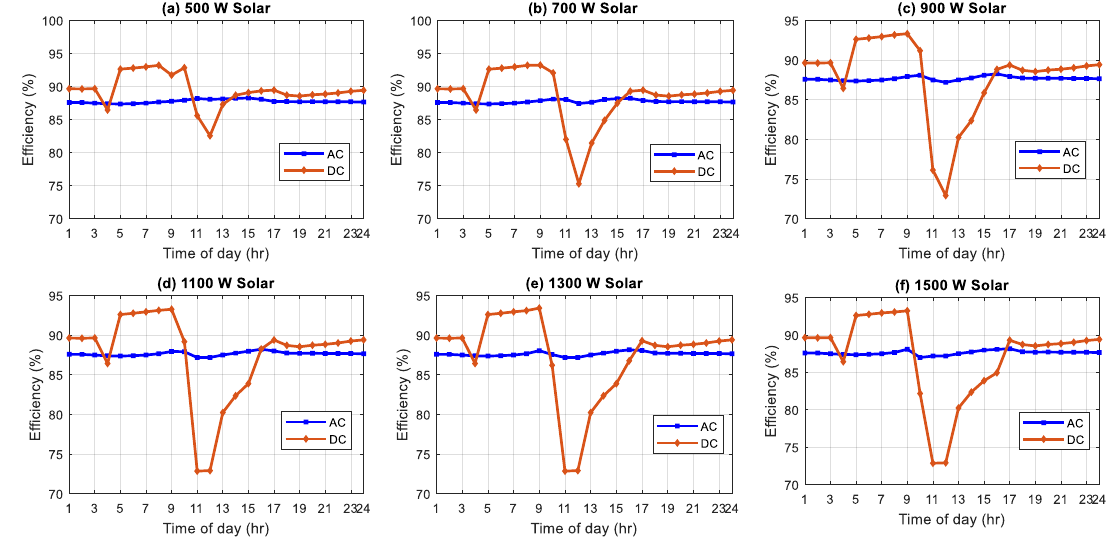
Figure 6. AC vs. DC system efficiency with varying solar capacity: ( a ) 500 W, ( b ) 700 W, ( c ) 900 W, Figure 6. AC vs . DC system efficiency with varying solar capacity: (a) 500 W, (b) 700 W, (c) 900 W, (d) ( d ) 1100 W, ( e ) 1300 W, and ( f ) 1500 1100 W, (e) 1300 W, and (f) 1500 W.